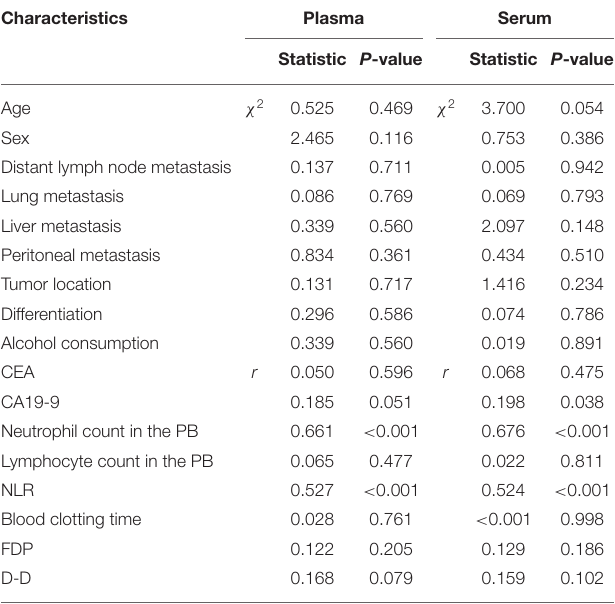
TABLE 5 | The relationships between the levels of NETs in the PB and clinicopathological features in advanced GC patients.